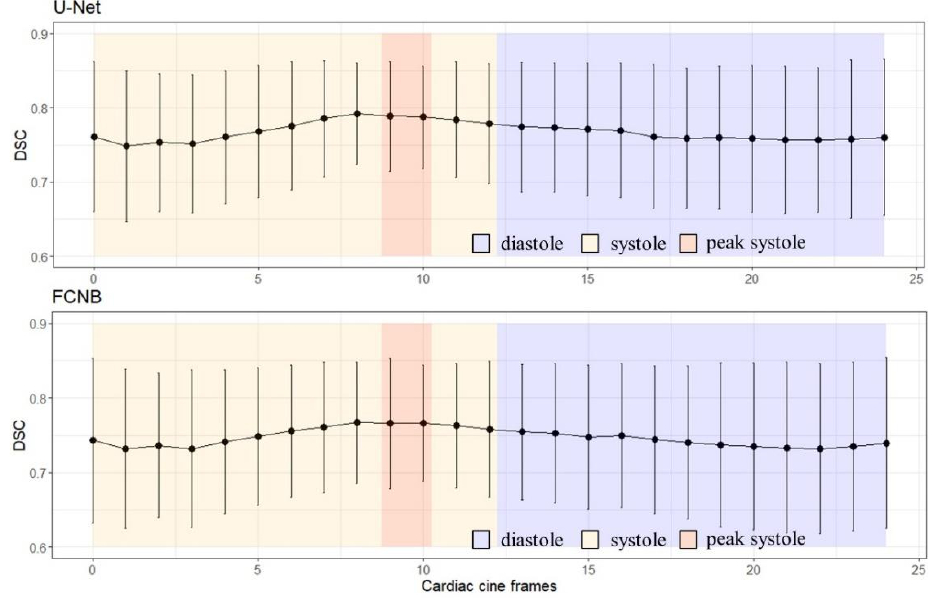
Figure A1. FCNs DSC performance varies along the cardiac cine frames with a maximum mean Dice and minimum standard deviation in systole.